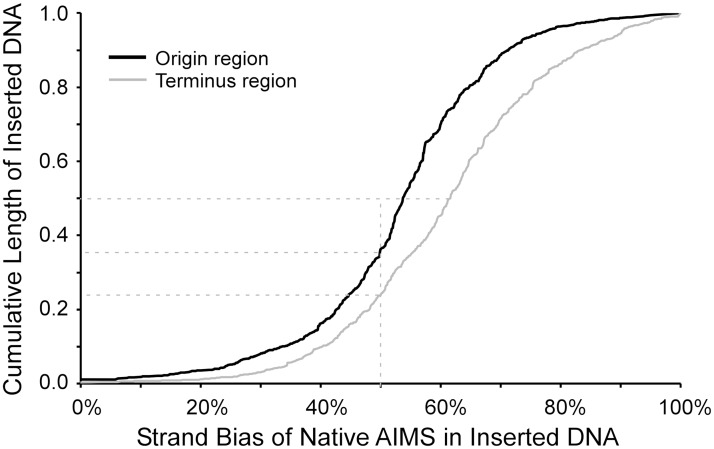
Loss of foreign DNA inserted in the terminus regions of genomes.A total of 10,707 insertions were catalogued in the genomes of γ-Proteobacteria; of these, 1597 insertions were located in the terminus-proximal 6% of the genomes, whereas 1220 insertions were located in the terminus-distal 6% of the genome (between 42 and 48% of the genome length from the terminus; the final 2% was ignored to accommodate differences in the lengths of chromosome arms). The cumulative length of the inserted fragments in each of these two regions is plotted against the strand-bias of native AIMS within each acquired fragment; as expected from Fig 5, DNA inserted near the replication terminus bear AIMS that are more strand-biased than fragments inserted near the replication origin. The shift of the strand-bias of AIMS in fragments inserted in the terminus region indicates a loss of 18% of the inserted fragments in this region.